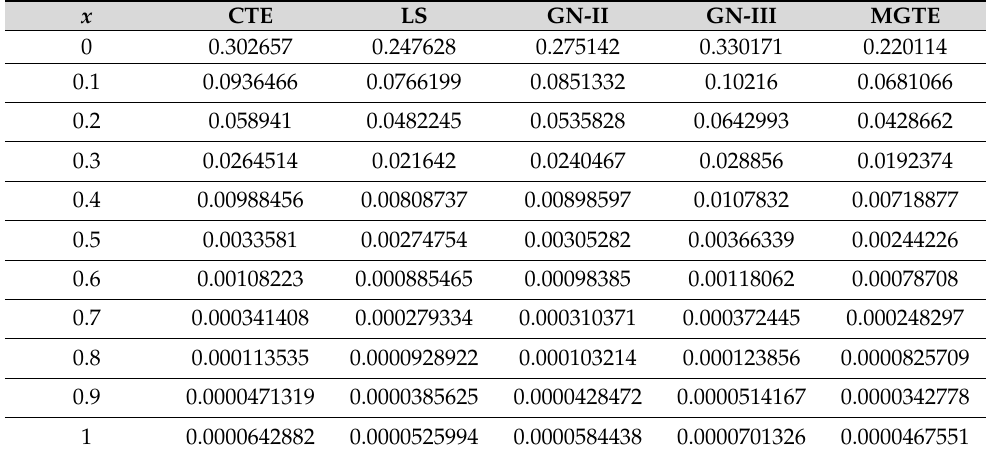
Table 3. The temperature change θ versus thermoelastic models.